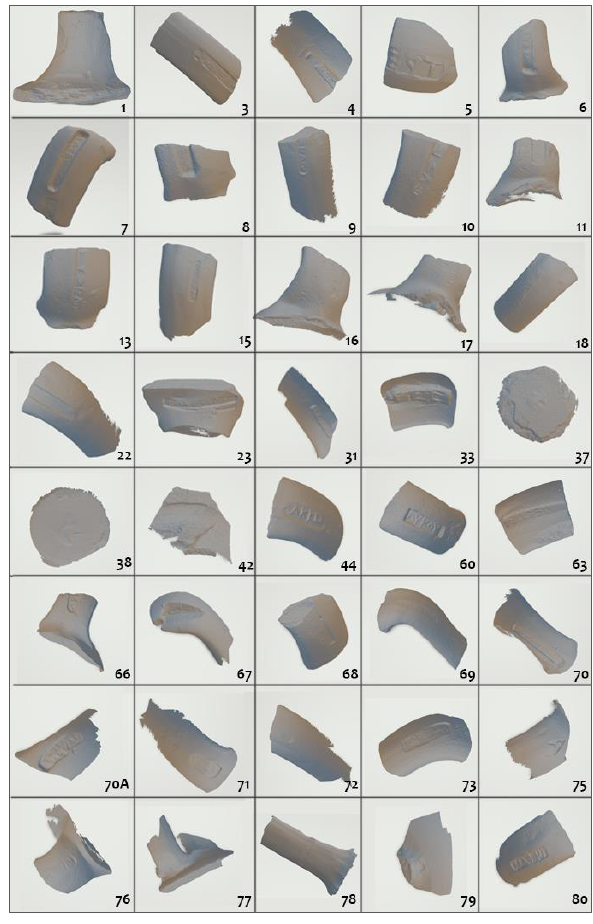
Figure 7 : Portion of the stamps acquired with structured light laser